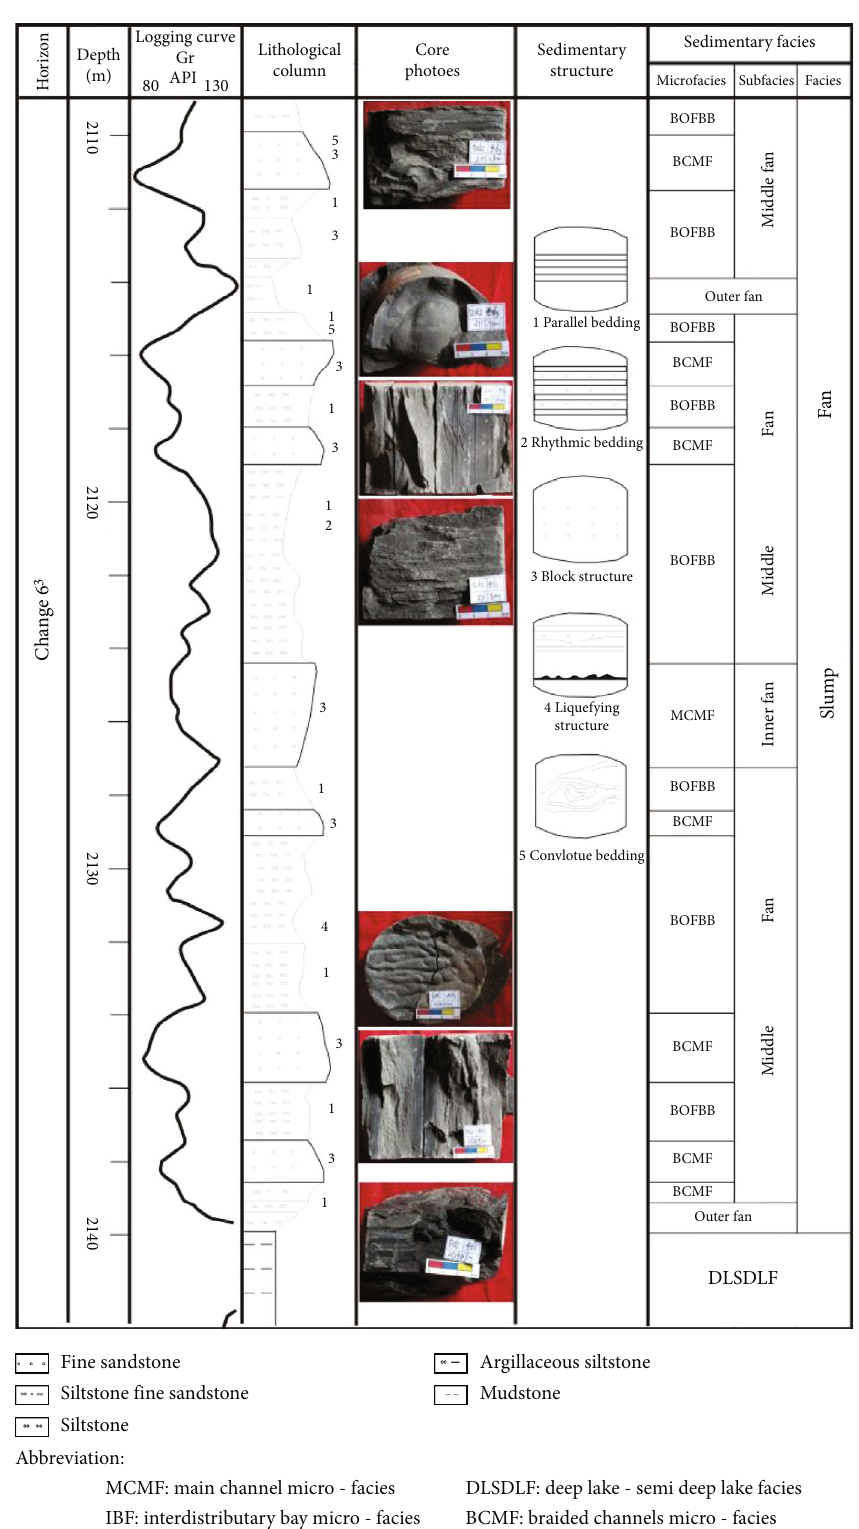
Figure 4: Slump fan facies of the Chang 6 3 Member, Bai162